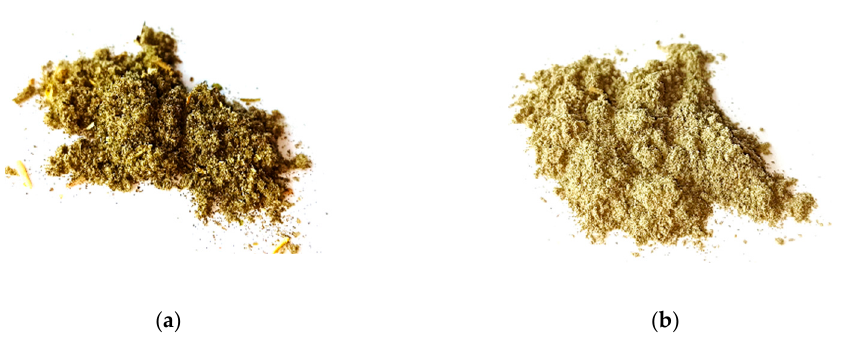
Figure 1. External morphology of ( a ) unmodified salvia filler (SO filler), and ( b ) montmorillonite (MMT)-modified SO filler.